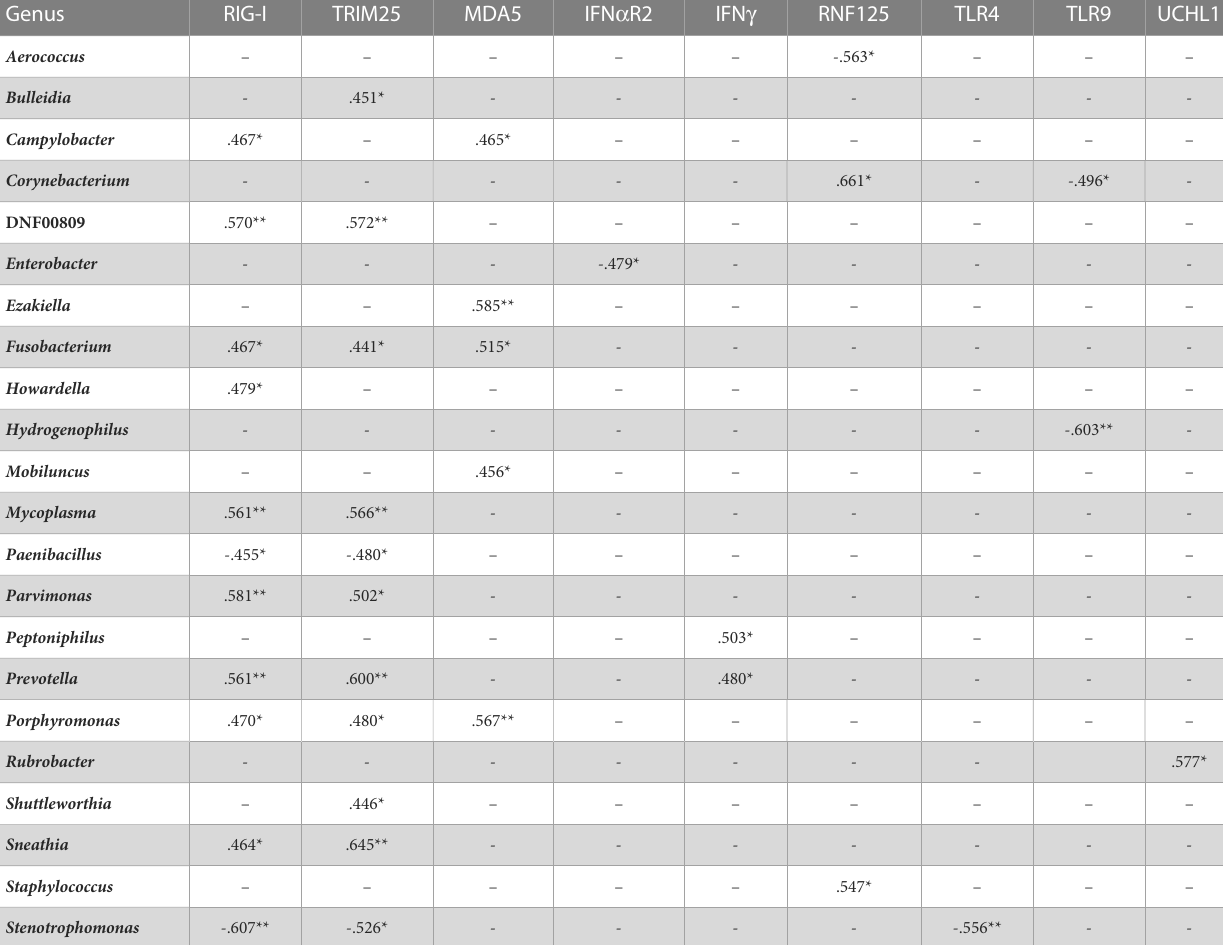
r=correlationcoef fi cient;-:comparison withnon-signi fi cativecorrelation;SpearmanCorrelationDegree:strongcorrelation:0.7 ≤ r ≤ 1or-1 ≤ r ≤ -0.7;moderatecorrelation:0.4 ≤ r<0.7or-0.7 ≤ r < -0.4; weak correlation: 0 < r < 0.4 or 0.4 < r <0; negative correlation: r < 0. * p < 0.05; ** p <